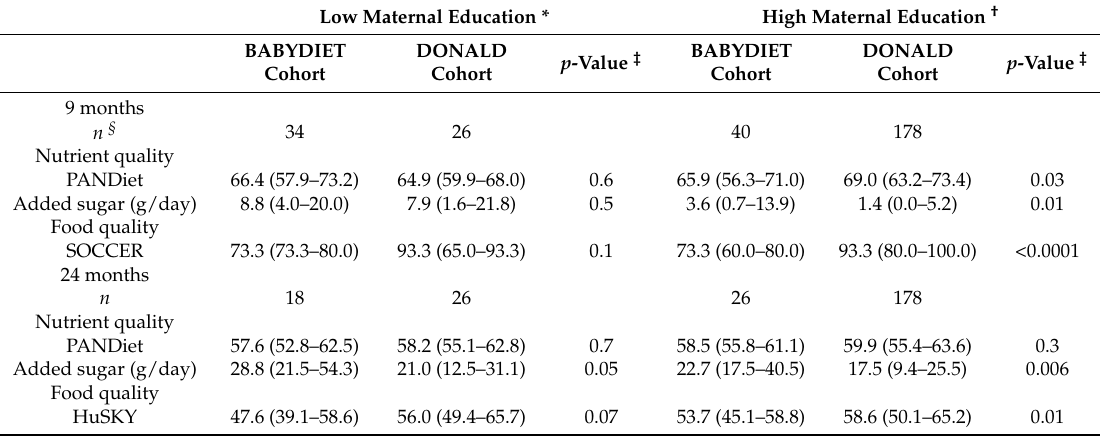
Table 5. Nutrient and food intake quality at nine and 24 months stratified by maternal educational level. Low Maternal Education * High Maternal Education † BABYDIET DONALD Cohort Cohort